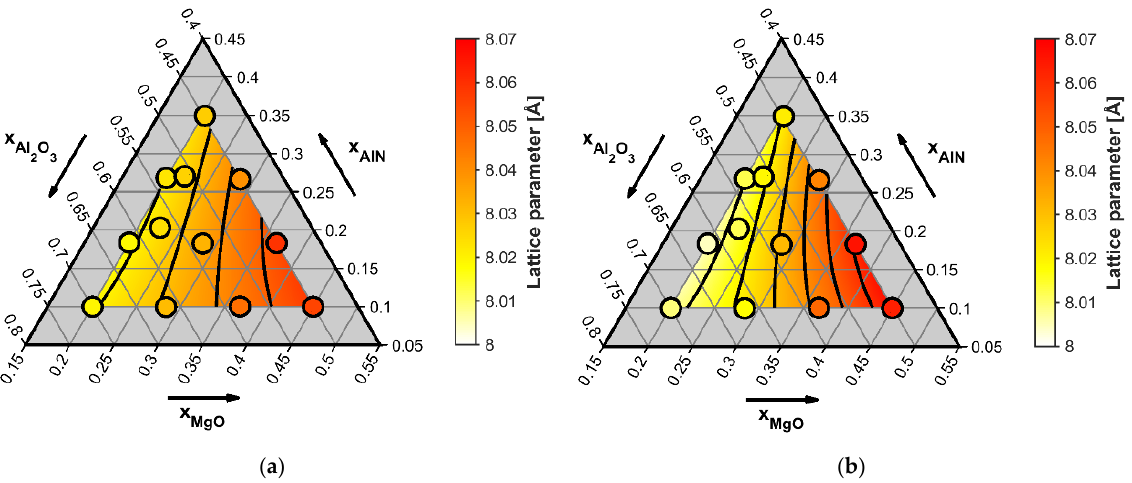
Figure 7. Mean lattice parameters of MgAlON as a function of the initial composition within the quasi-ternary MgO-AlN-Al 2 O 3 system after 3 h ( a ) and 6 h ( b ) of sintering time at 1500 °C in nitrogen atmosphere as a function of the initial composition (cf. Supplementary Table S2). The black contour lines correspond to constant lattice parameters.